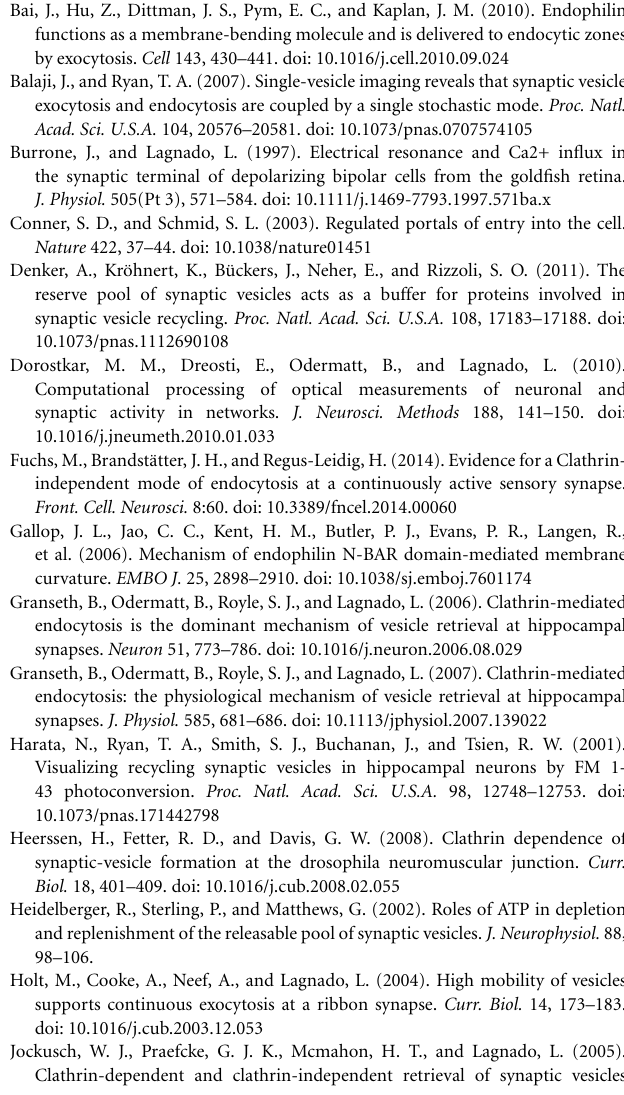
Supplementary Table 1 | Sequences of primers used for generating transgenic zebrafish